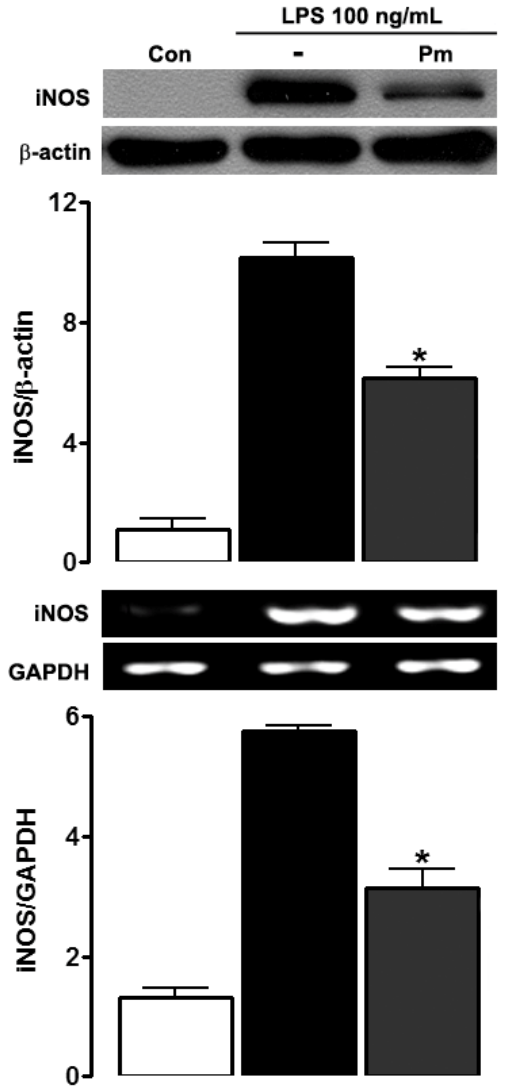
Figure 3. Effects of P. mirifica extract on LPS-induced iNOS protein and mRNA expression. HAPI cells (5 × 10 5 cells/well) were pretreated with the ethyl acetate extract of P. mirifica (100 ng/mL) for 1 h followed by stimulation with LPS (100 ng/mL) for 6 h. The expression of iNOS protein was evaluated by Western blot analysis (upper panel), and iNOS mRNA (lower panel) was determined with semiquantitative RT-PCR. GAPDH was used as a reference for equal loading. The graphs illustrate levels of expression quantitated using a densitometer; for mRNA, the relative expression levels of iNOS transcript were normalized with respect to GAPDH. Data are representative of three separate experiments. Values are the mean ± SD. * p < 0.05 compared with the LPS-treated group.